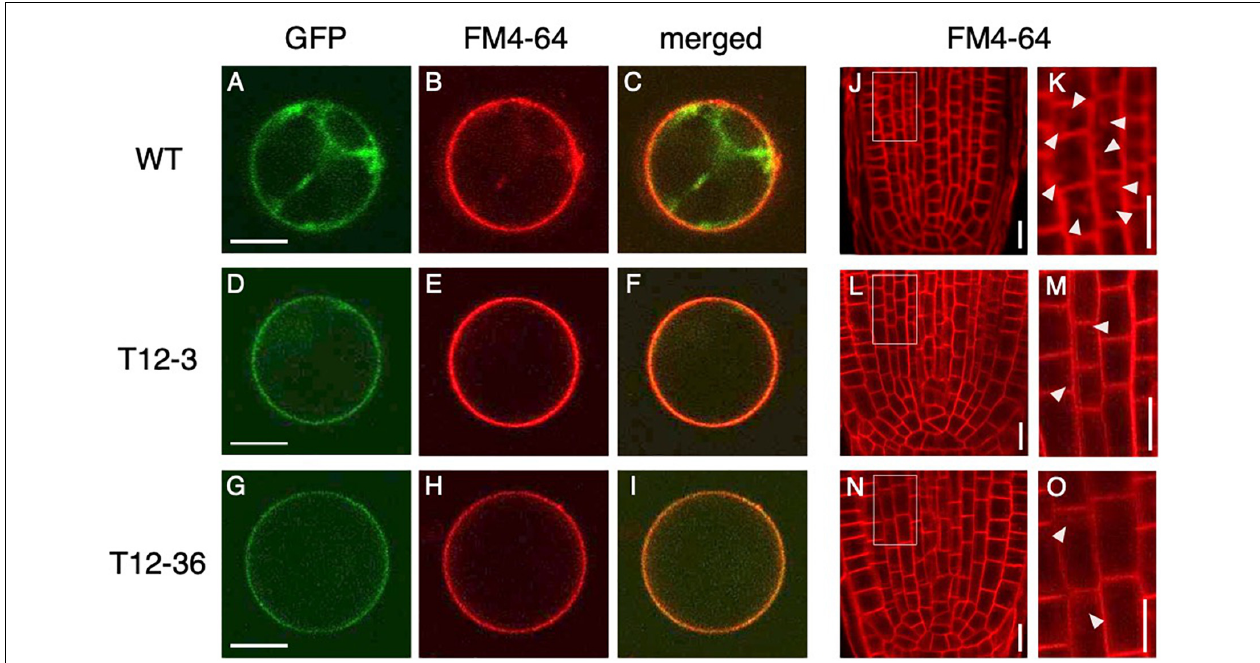
FIGURE 3 | Analysis of endocytic activity and OsPIN1b localization in wild-type (WT) and the mutants. (A–I) Rice protoplasts expressing 35S - OsPIN1b - GFP stained with an endocytic tracer FM4-64 in WT (A–C) , T12-3 (D–F) , and T12-36 (G–I) . GFP (A,D,G) , FM4-64 (B,E,H) signals, and the merged images (C,F,I) are shown. (J–O) FM4-64 uptake in root tips of S-type LRs in WT (J,K) , T12-3 (L,M) , and T12-36 (N,O) . Root tips (J,L,N) and enlarged views of the boxed area (K,M,O) are shown. Arrowheads point endocytic compartments in cortical cells. Scale bars = 10 µ m.